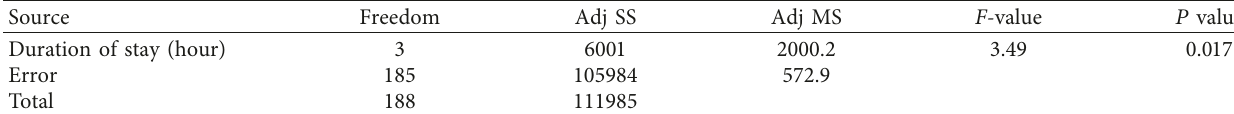
Table 3: Variance analysis table for family size and travel